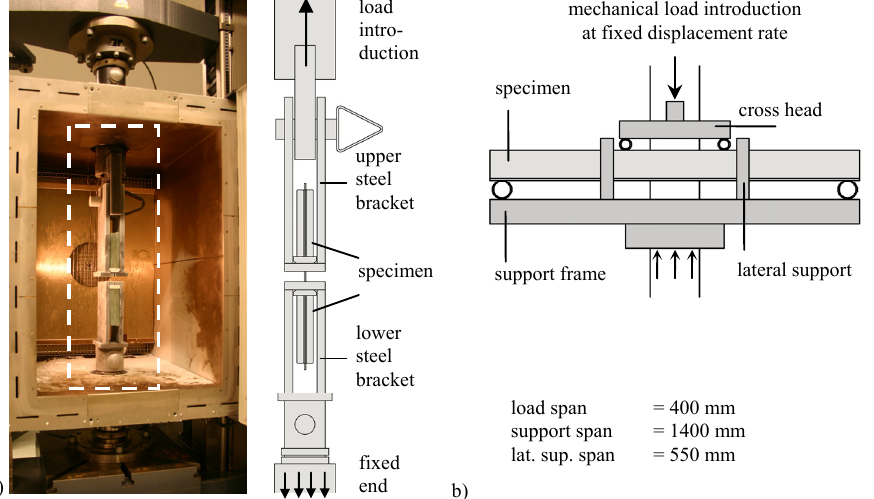
Figure 2: Test setup for the pull-out tests (left) and beam tests (right).